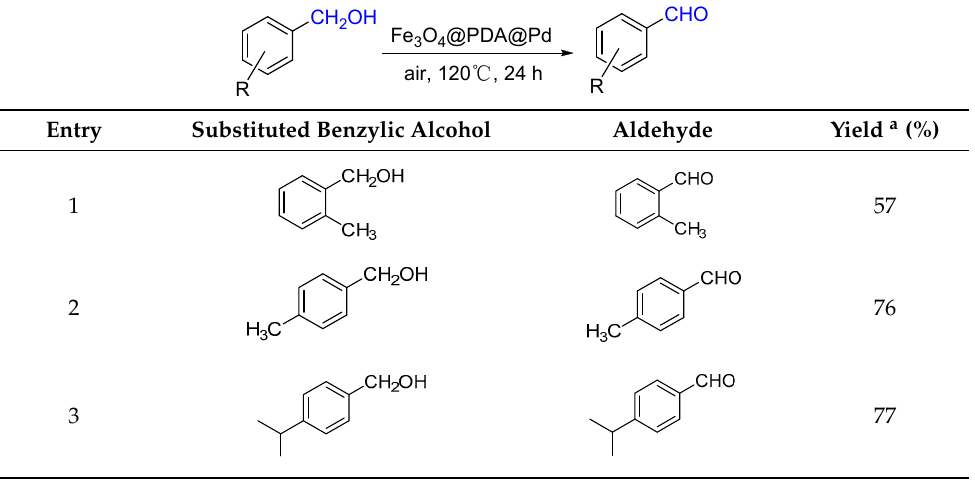
Table 3. Catalytic dehydrogenation of substituted benzylic alcohols to aldehydes.